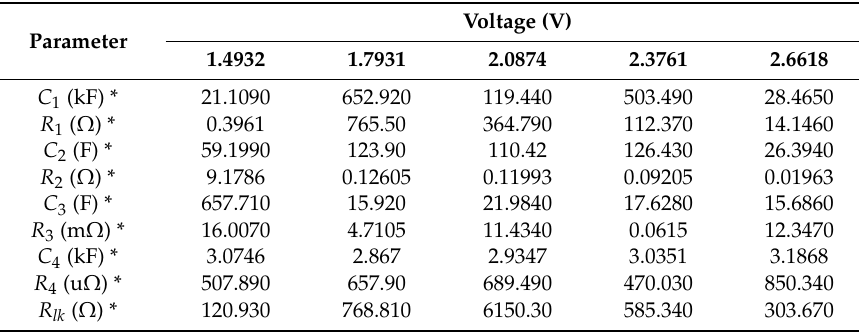
Table A6. Parallel Model Parameters with current profile i 3